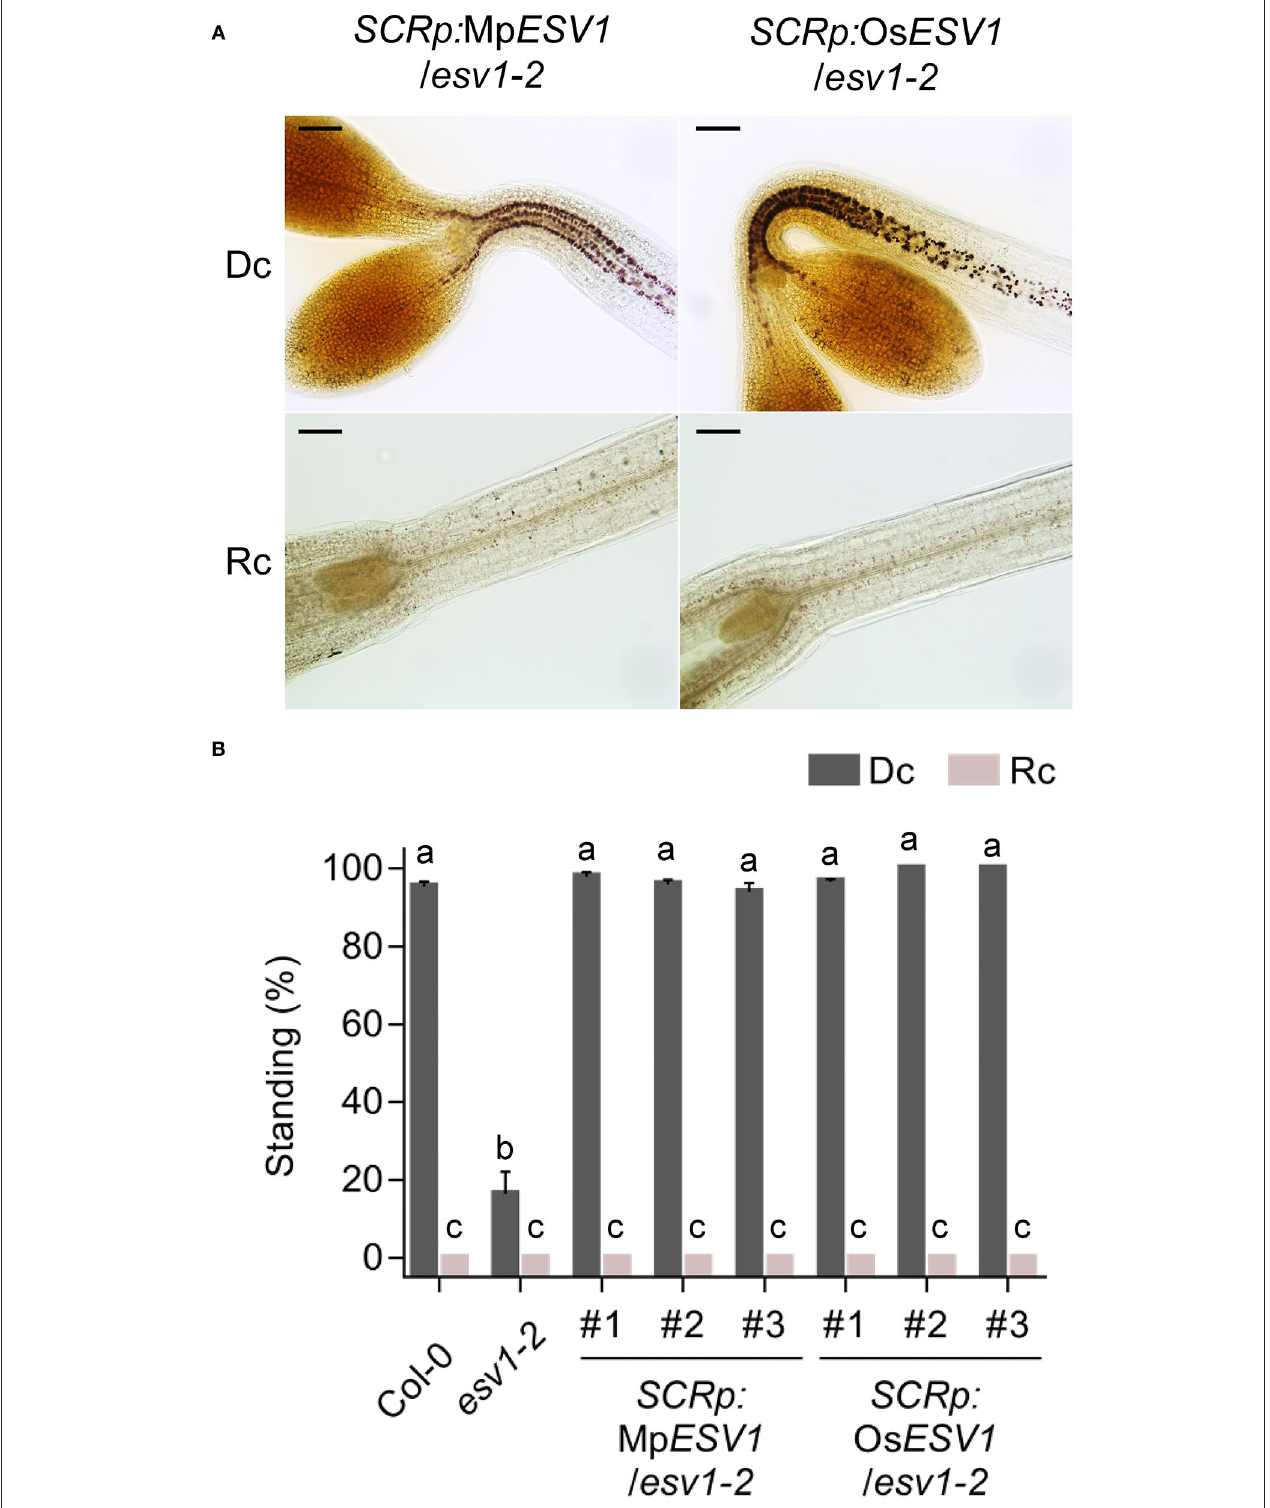
FIGURE 5 | Liverwort and rice ESV1 genes can rescue the Arabidopsis ESV1 mutant. (A) Liverwort and rice ESV1 rescue endodermal starch granules in the Arabidopsis ESV1 mutant background. Transgenic seedlings expressing either liverwort or rice ESV1 under the SCR promoter in the ESV1-2 mutant background ( SCRp: Mp ESV1 / ESV1-2 , SCRp: Os ESV1 / ESV1-2, were grown for 3 days either in the dark (Dc) or in red light (Rc). Then, starch granules were visualized by staining